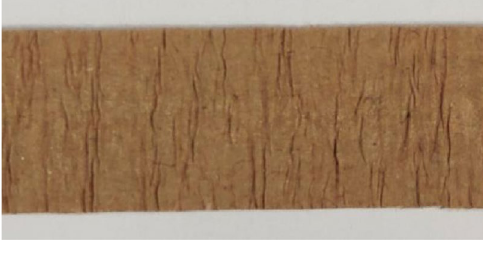
Fig. 20 15 mm wide sample of paper G